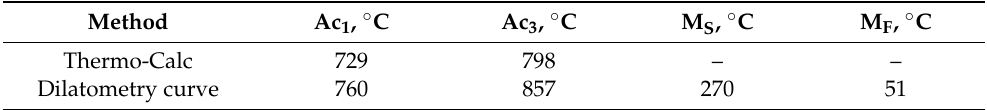
Table 1. Critical points of the Fe - 0.44C steel.